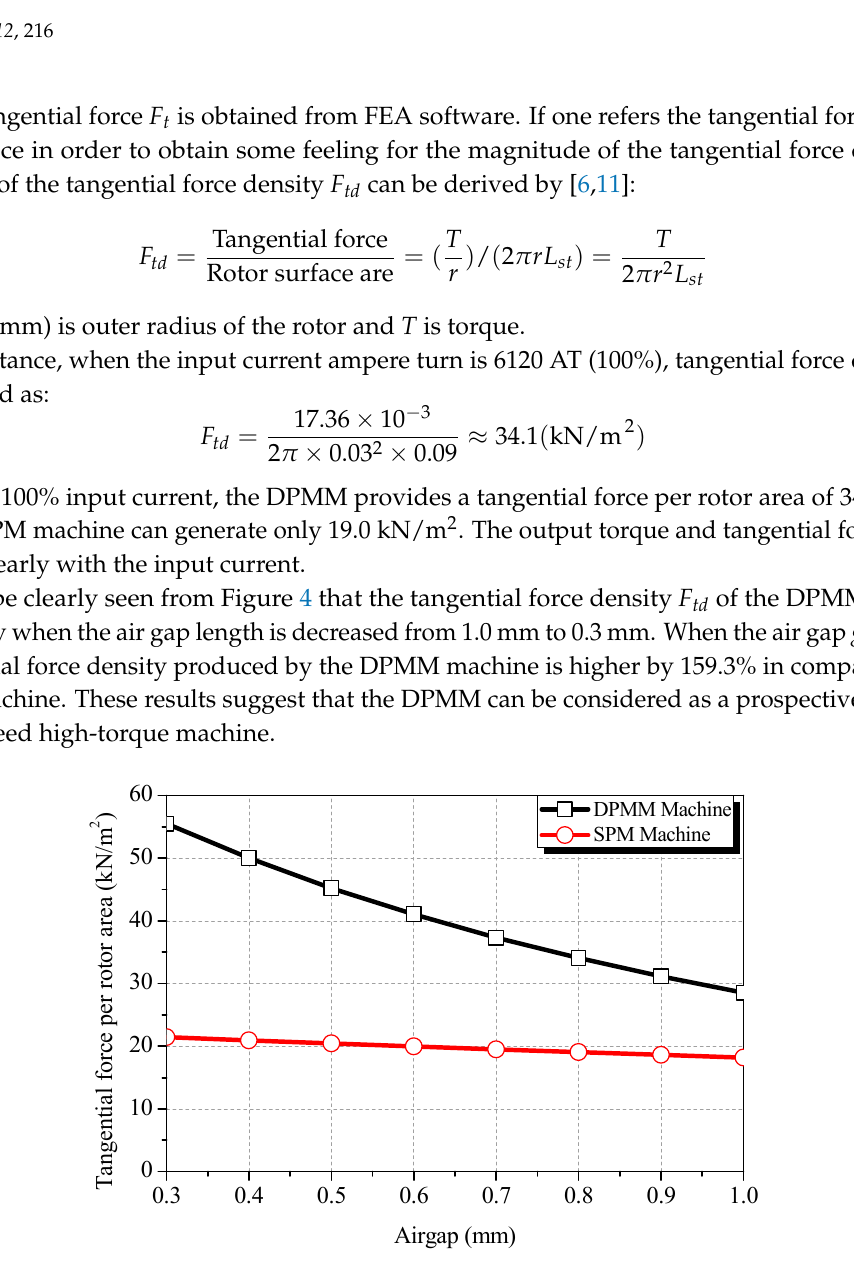
Figure 4. Tangential force density comparison for different air gap lengths.